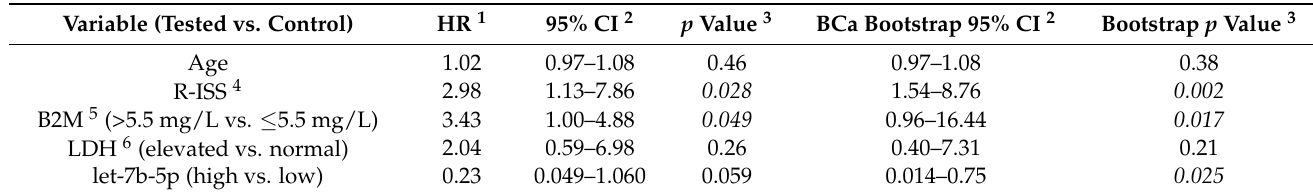
Table 4. Cox regression analysis regarding the prognostic potential of circulating let-7b-5p status for the OS of MM patients. Variable (Tested vs. Control)